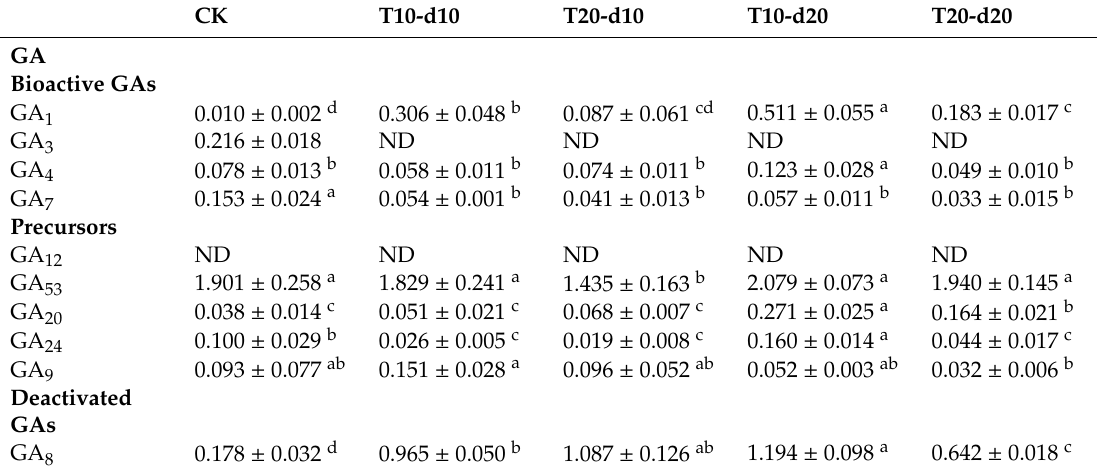
Figure 4. Gene expression pattern of the gibberellin (GA)-related genes in di ff erent treatments. Green indicates a decrease and red an increase in gene expression (see color set scale on top right corner). Detailed information on each gene and its expression level is listed in Table S5. Table 3. Levels of gibberellins (GAs) in the di ff erent